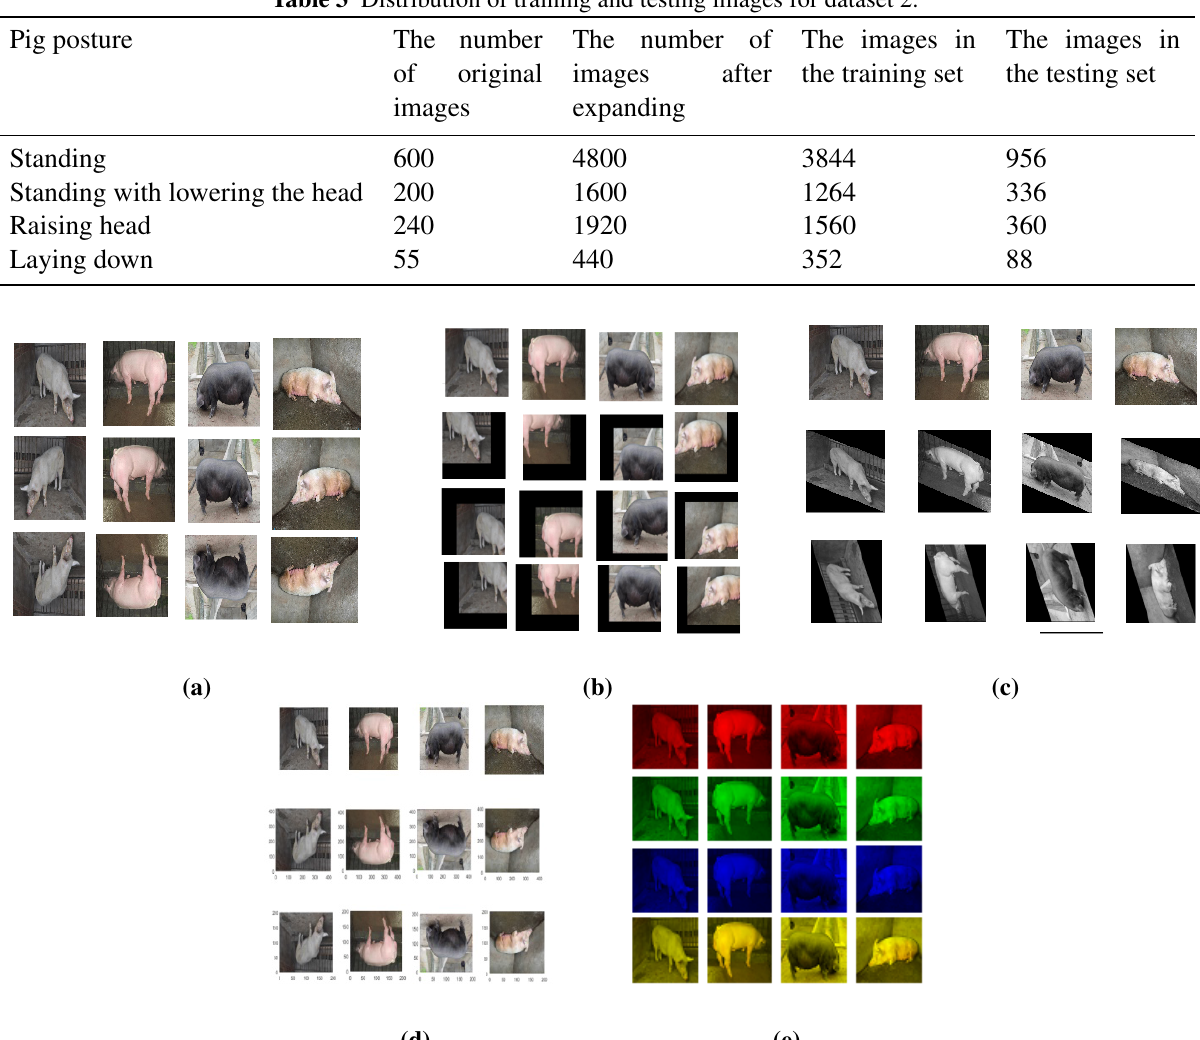
Table 3 Distribution of training and testing images for dataset 2.